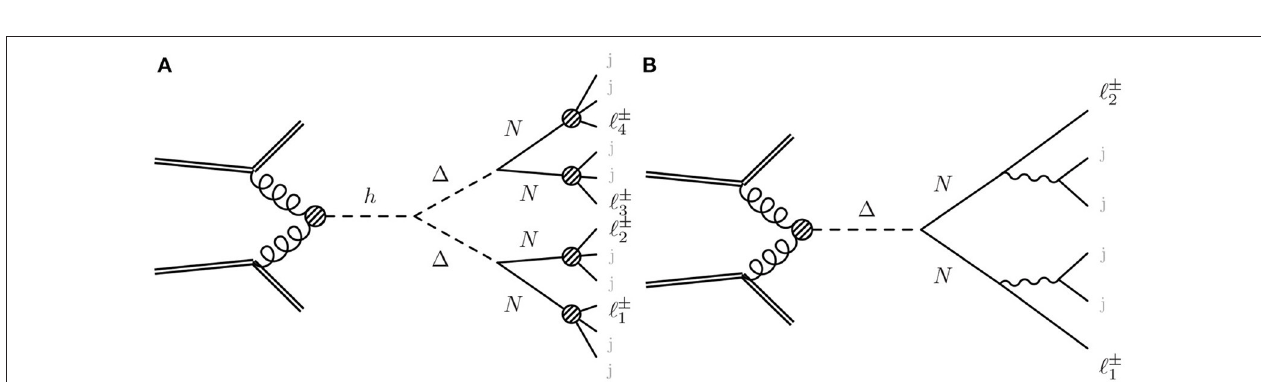
FIGURE 31 | ATLAS 95% CLs exclusion at 13 TeV after L (A) pure e ± e ± , (B) pure µ ± µ ± , (C) pure e ± µ ± , and (D) mixed final-states [ 460].